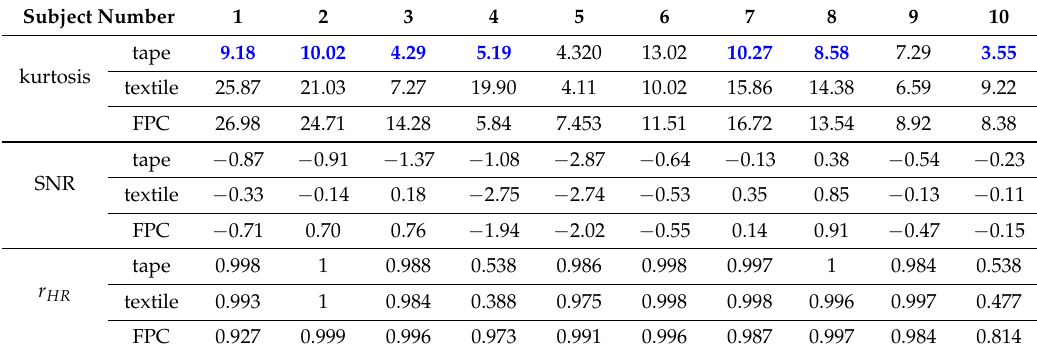
Table 8. Quality indexes of ECG signals measured when subjects are lying on their side. (The blue number show that the kurtosis of the copper foil tape on seven subjects is the